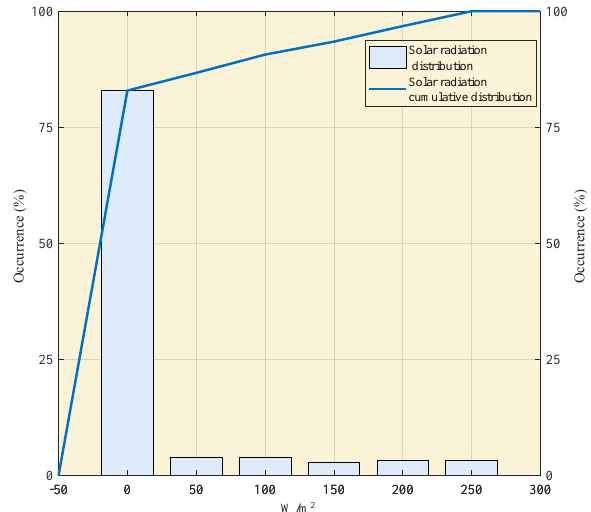
Figure 14. Distribution function and cumulative distribution function of solar radiation for 7